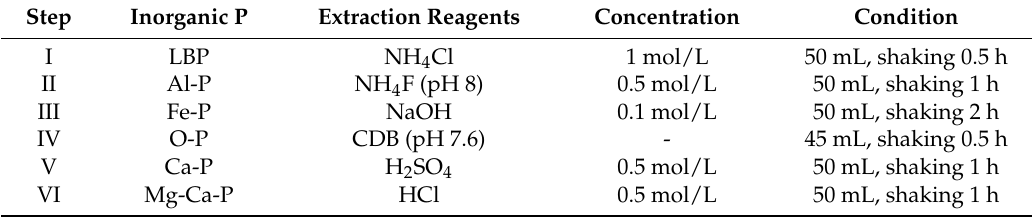
Table 2. Inorganic phosphorus by a sequential extraction for filter media